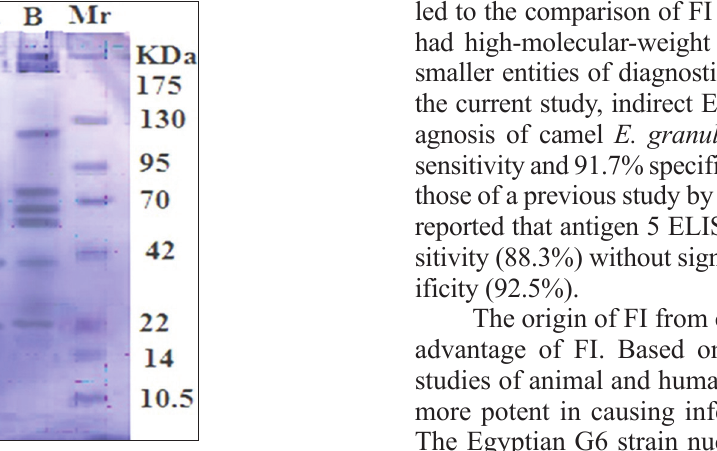
Figure-5: Antigenic bands under reducing condition recognized by naturally infected camel serum in crude HCF antigen (Lane B) and purified FI (Lane A). Standard’s molecular weight (Lane